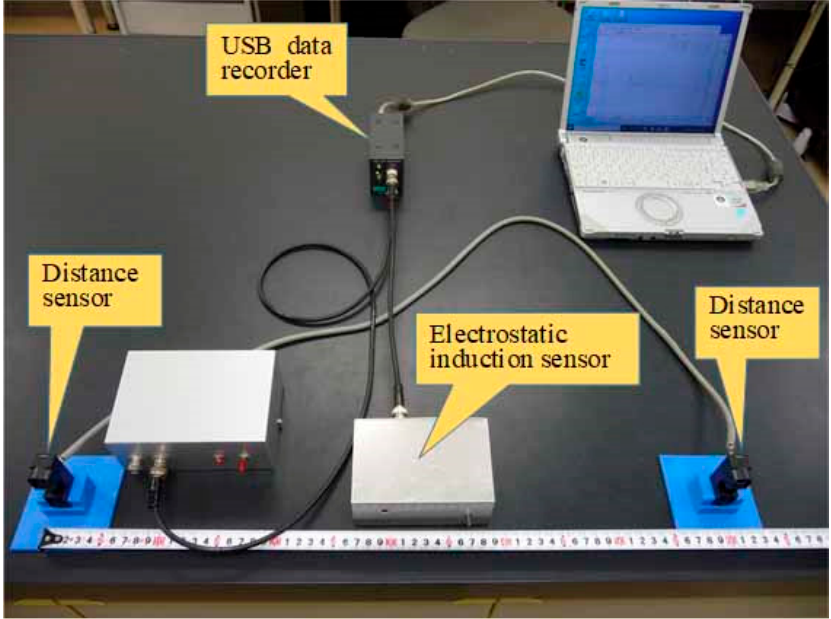
Figure 6. Photograph of the sensor system for the measurement of the electric potential of the human body by walking motion.